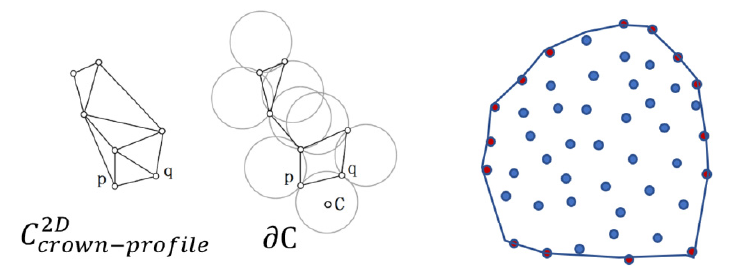
Figure 12. Using the alpha shapes algorithm to get the shape of the tree crown, and the red spots are the edge points.